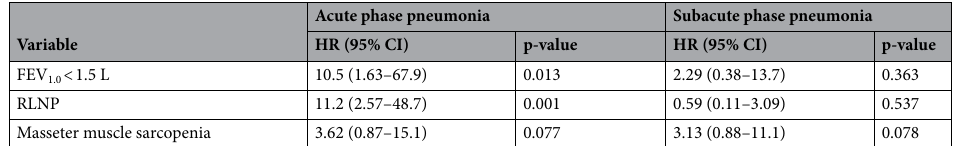
Table 2. Subgroup analysis of risk factors for acute phase and subacute phase pneumonia in patients undergoing esophagectomy. FEV 1.0, forced expiratory volume in one second; RLNP, recurrent laryngeal nerve